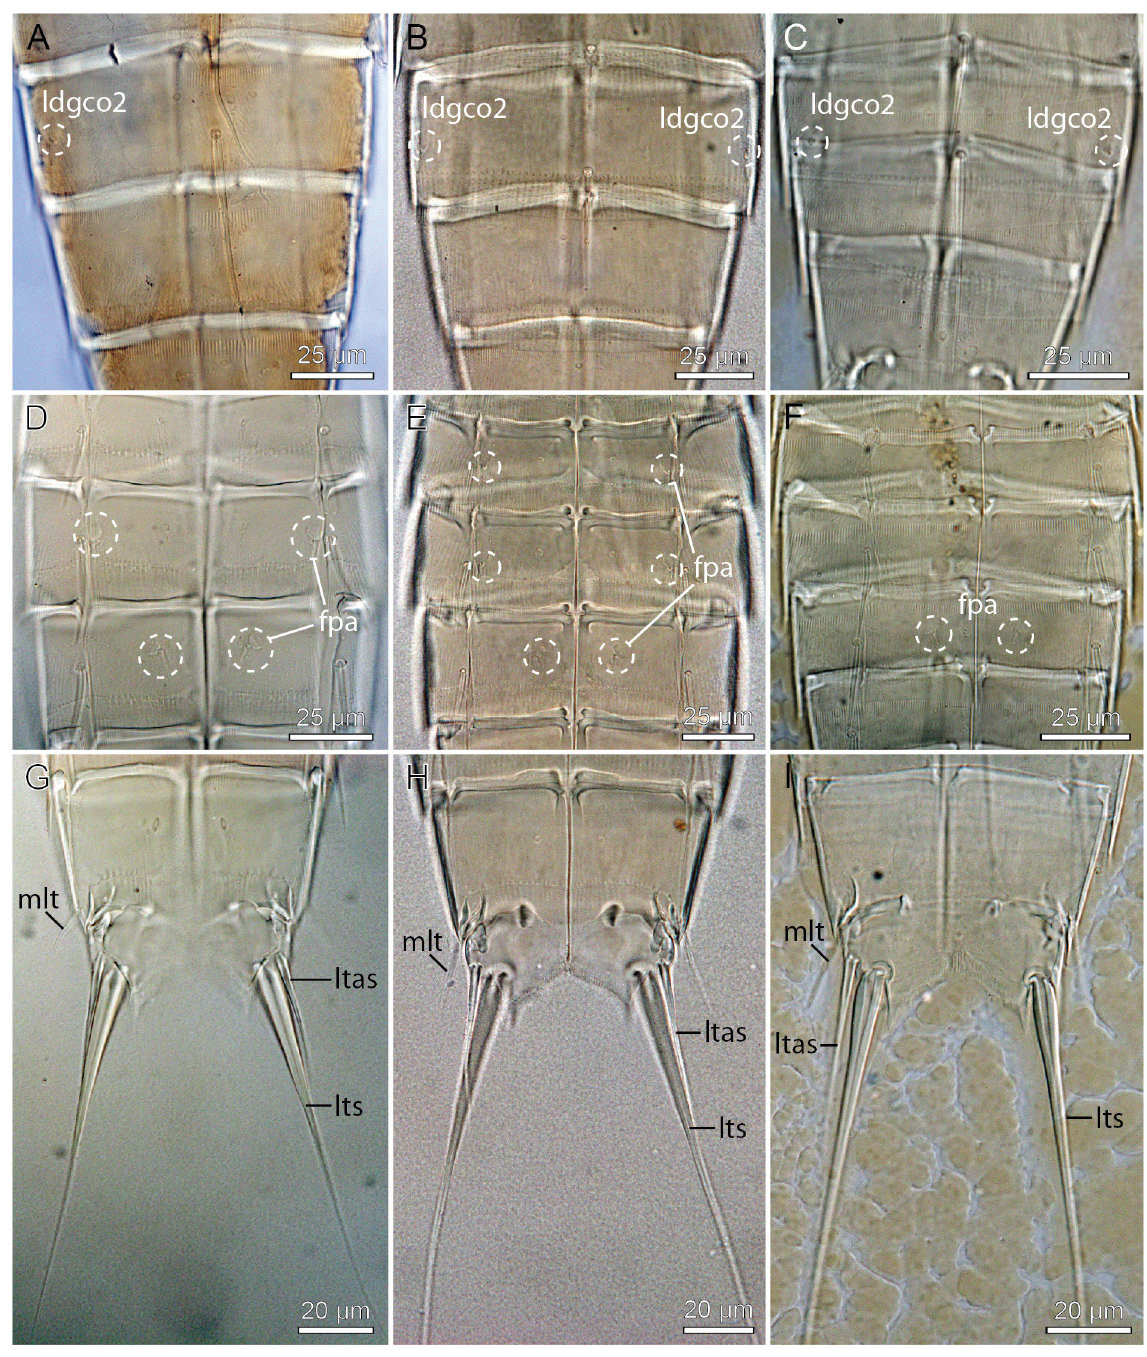
Fig. 8. Comparative light micrographs showing selected details of E. pacificus Schmidt, 1974. A . Holotype, ♀ (USNM-53335). D–G . Paratype (USNM-53336). B, E, H . E. kozloffi Higgins, 1977. Holotype, ♀ (USNM-53337). C, F, I . E. sublicarum Higgins, 1977. Paratype, ♀ (USNM-54399). A–C . Segments 8 to 9, dorsal view, showing presence of glandular cell outlets type 2 on segment 8. D–F . Segments 6 to 8, ventral view, position and appearance of sexually dimorphic female papillae. G–I . Segments 10 to 11, with midlateral tubes on segment 10, and lateral terminal